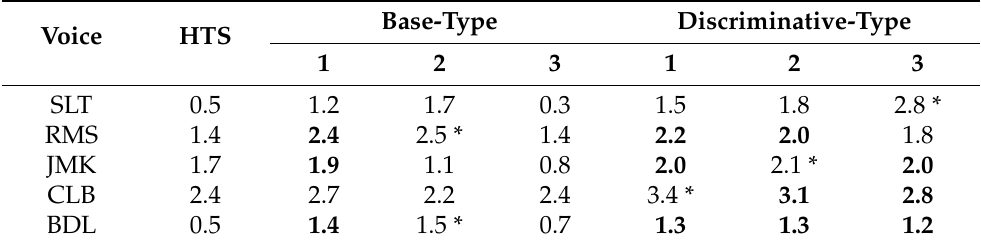
Table 4. SegSNR f Results for the hierarchical clustering levels. The higher values represent better results. * indicates is the best result. In bold are the results which are not significantly different from the best, according to Tukey’s HSD test.